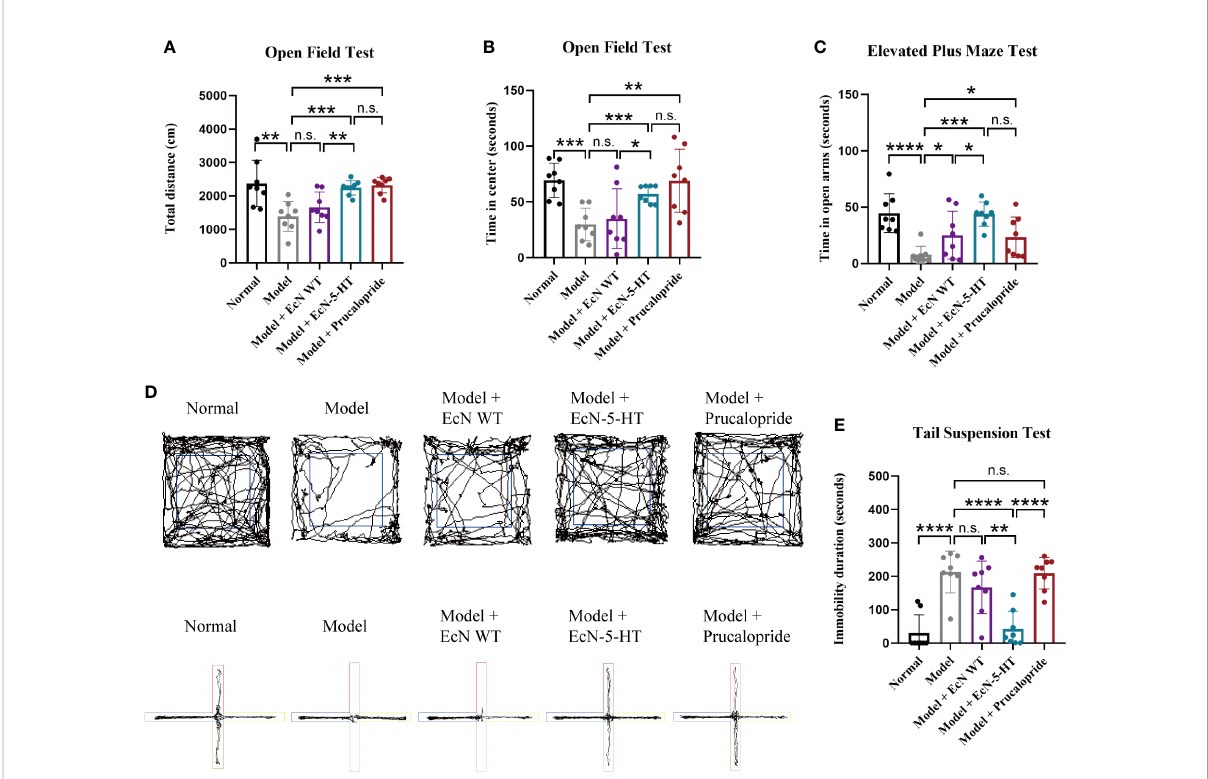
FIGURE 4 EcN-5-HT ameliorated loperamide-induced behavior disorders. (A) Open fi eld test (OFT). (B) Representative tracking plots of the open fi eld. (C) Elevated plus maze test (EPMT). (D) Representative tracking plots of the elevated plus maze test. (E) Tail suspension test (TST). Mean values ± SDs are presented, p values were calculated using unpaired t-test. *p < 0.05, **p < 0.01, ***p < 0.001 and ****p < 0.0001, n.s.: not signi fi